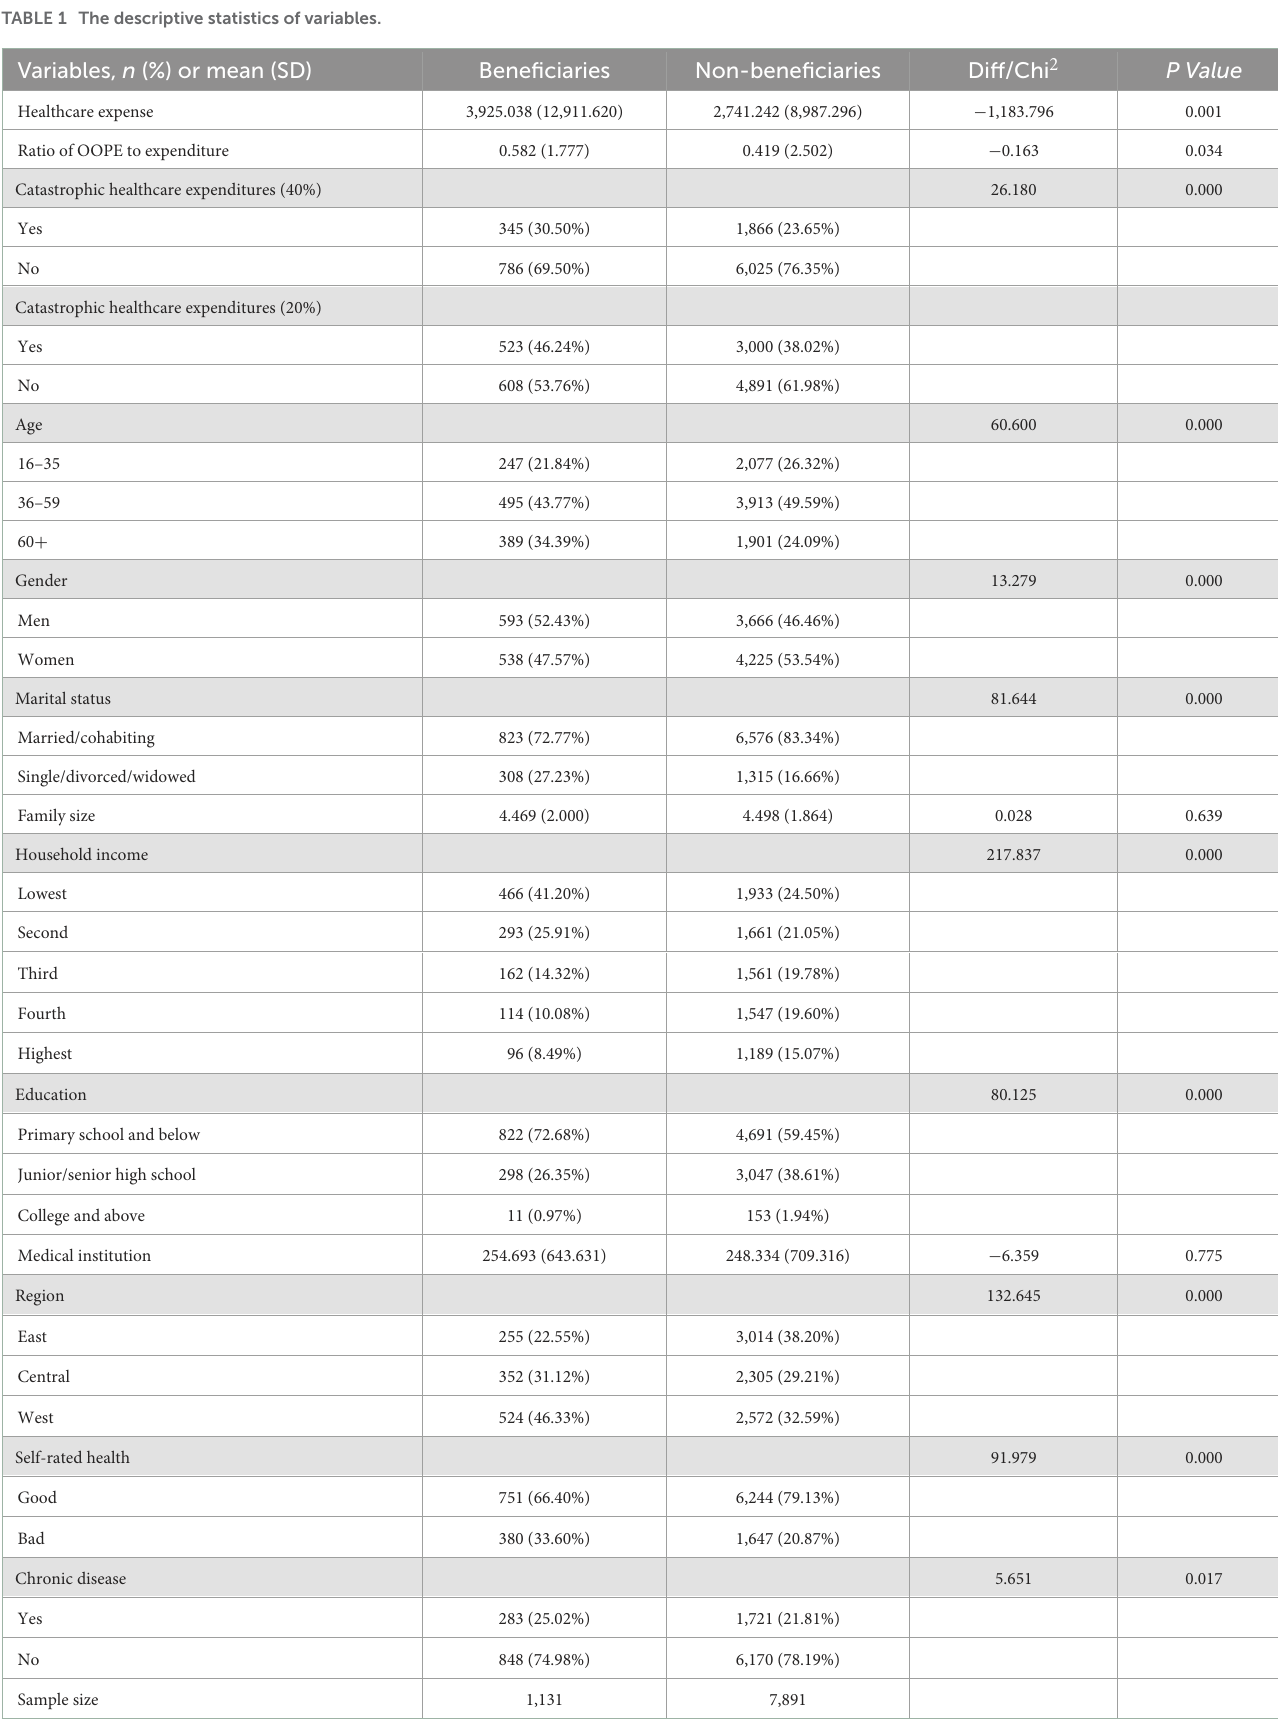
TABLE 1 The descriptive statistics of